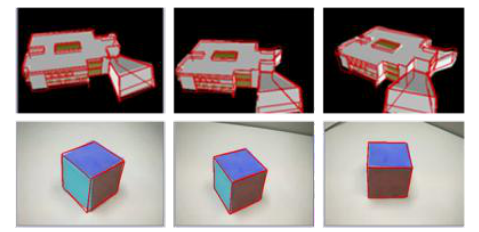
Figure 14. PS tracking of synthetic (top) and real (bottom) sequences.